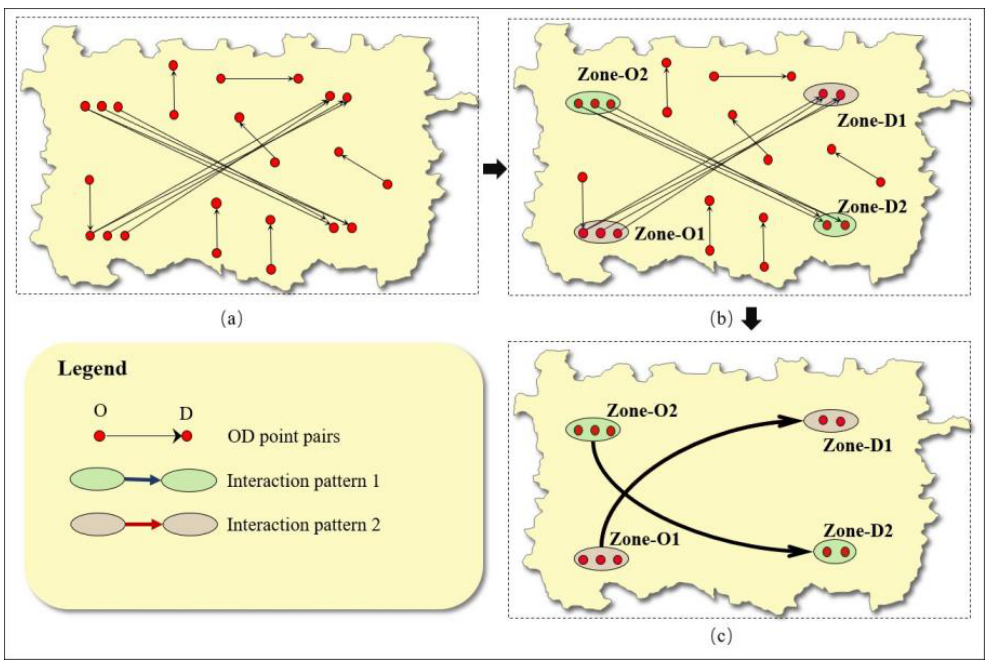
Figure 1. Example and analytical methods for point-to-point flow data. ( a ) Point-to-point flow data, ( b ) points-to-points flow data, and ( c ) points-to-points flow patterns.